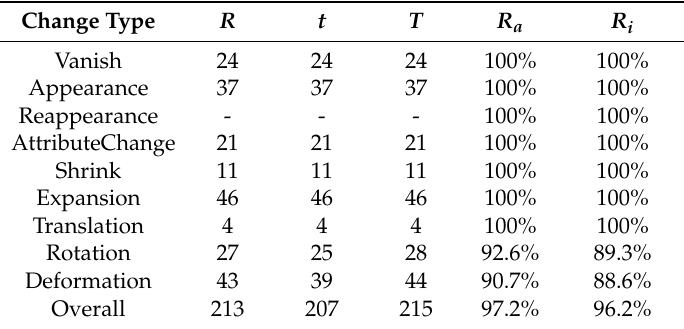
Table 5. Detection result of change type in study area.